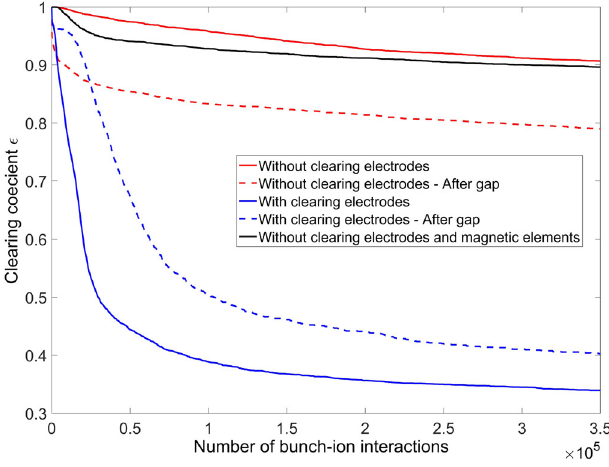
FIG. 9. Clearing coefficient ϵ vs the time, expressed in bunch- ion interactions, for different simulations for CO þ ions. Blue lines correspond to simulations with clearing electrodes and red lines without. Plain lines correspond to simulations of the ion cloud generated with an uniform distribution. Dashed lines correspond to simulations of the ion cloud after a clearing gap. The black plain line corresponds to a simulation without clearing electrodes and magnetic